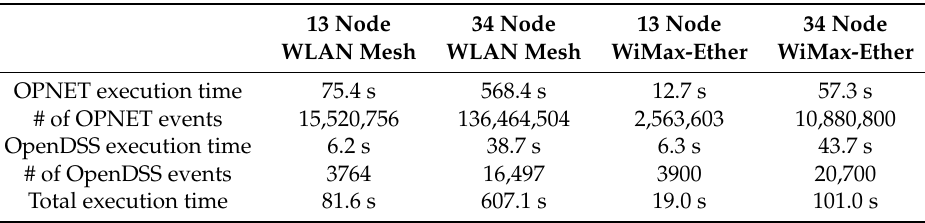
Table 4. Execution time of simulation